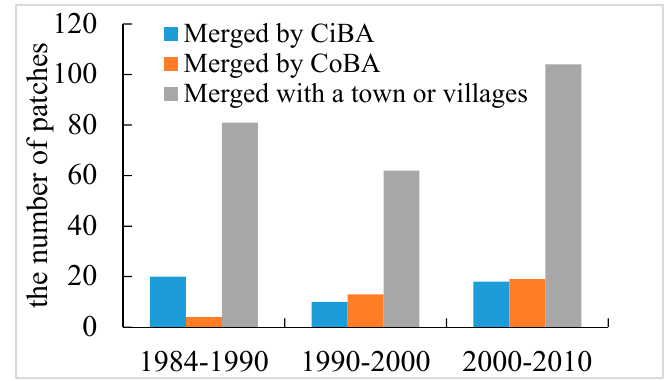
Figure 5. The variation of settlement in different merge types.